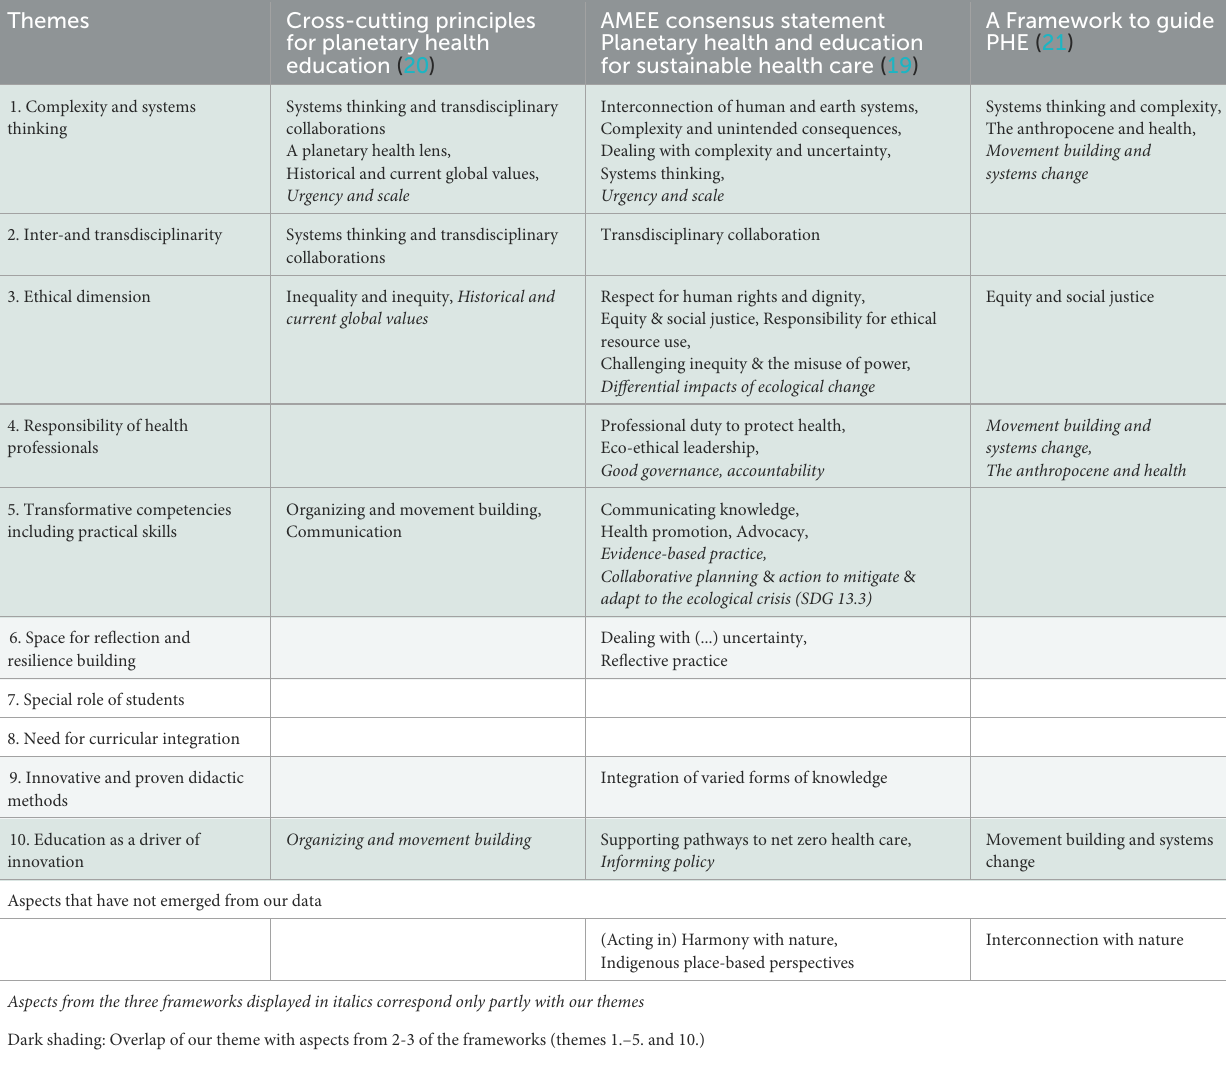
TABLE 4 Comparison of our ten themes with three international frameworks for planetary health